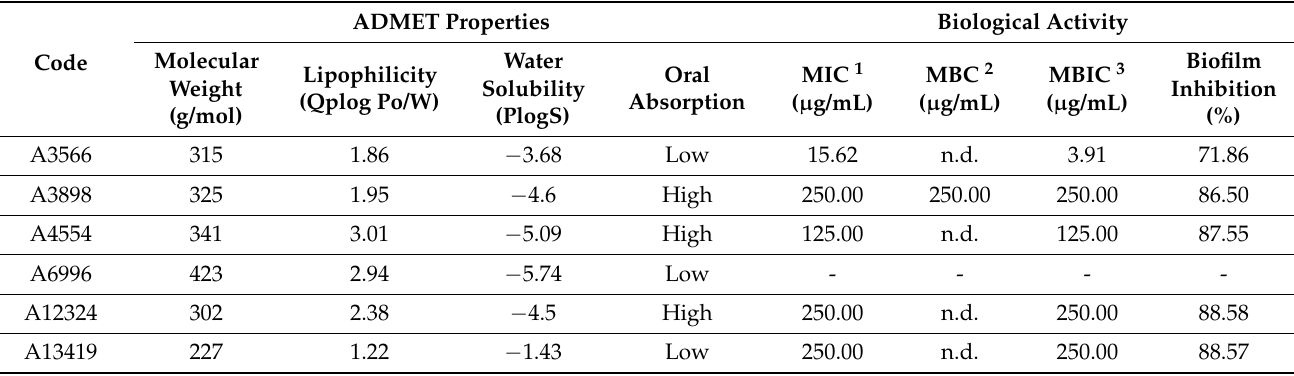
Table 2. ADMET properties and results of the microbiological assays of the selected